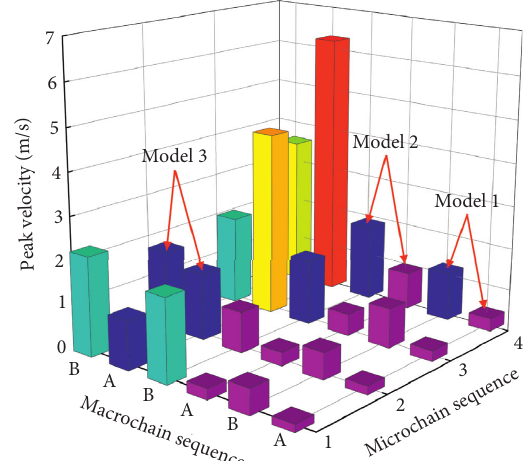
Figure 9: Distribution of peak velocity of rock